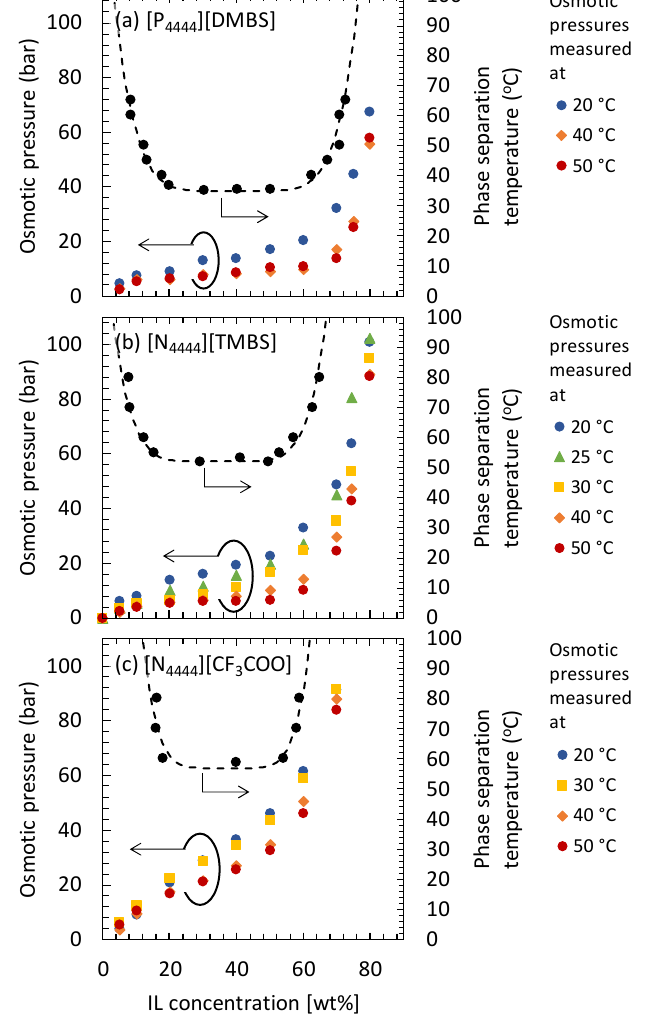
Figure 3. Phase diagram and temperature dependency of the osmotic pressure of thermo-responsible DS at different temperatures. ( a ) [P 4444 ][DMBS], ( b ) [N 4444 ][TMBS], and ( c ) [N 4444 ][CF 3 COO]. The data other than the osmotic pressure of [N 4444 ][TMBS] aqueous solution measured at 25 ◦ C were those previously reported in Ref. [32]. Reproduced with permission from Ref. [32]. Elsevier, 2021.